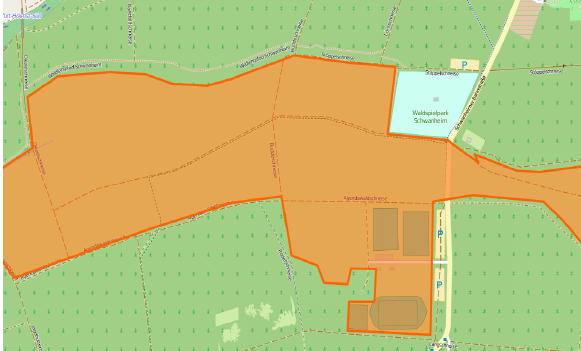
Figure 6: An entity problematic classified as grass , 1st recom- mendation park